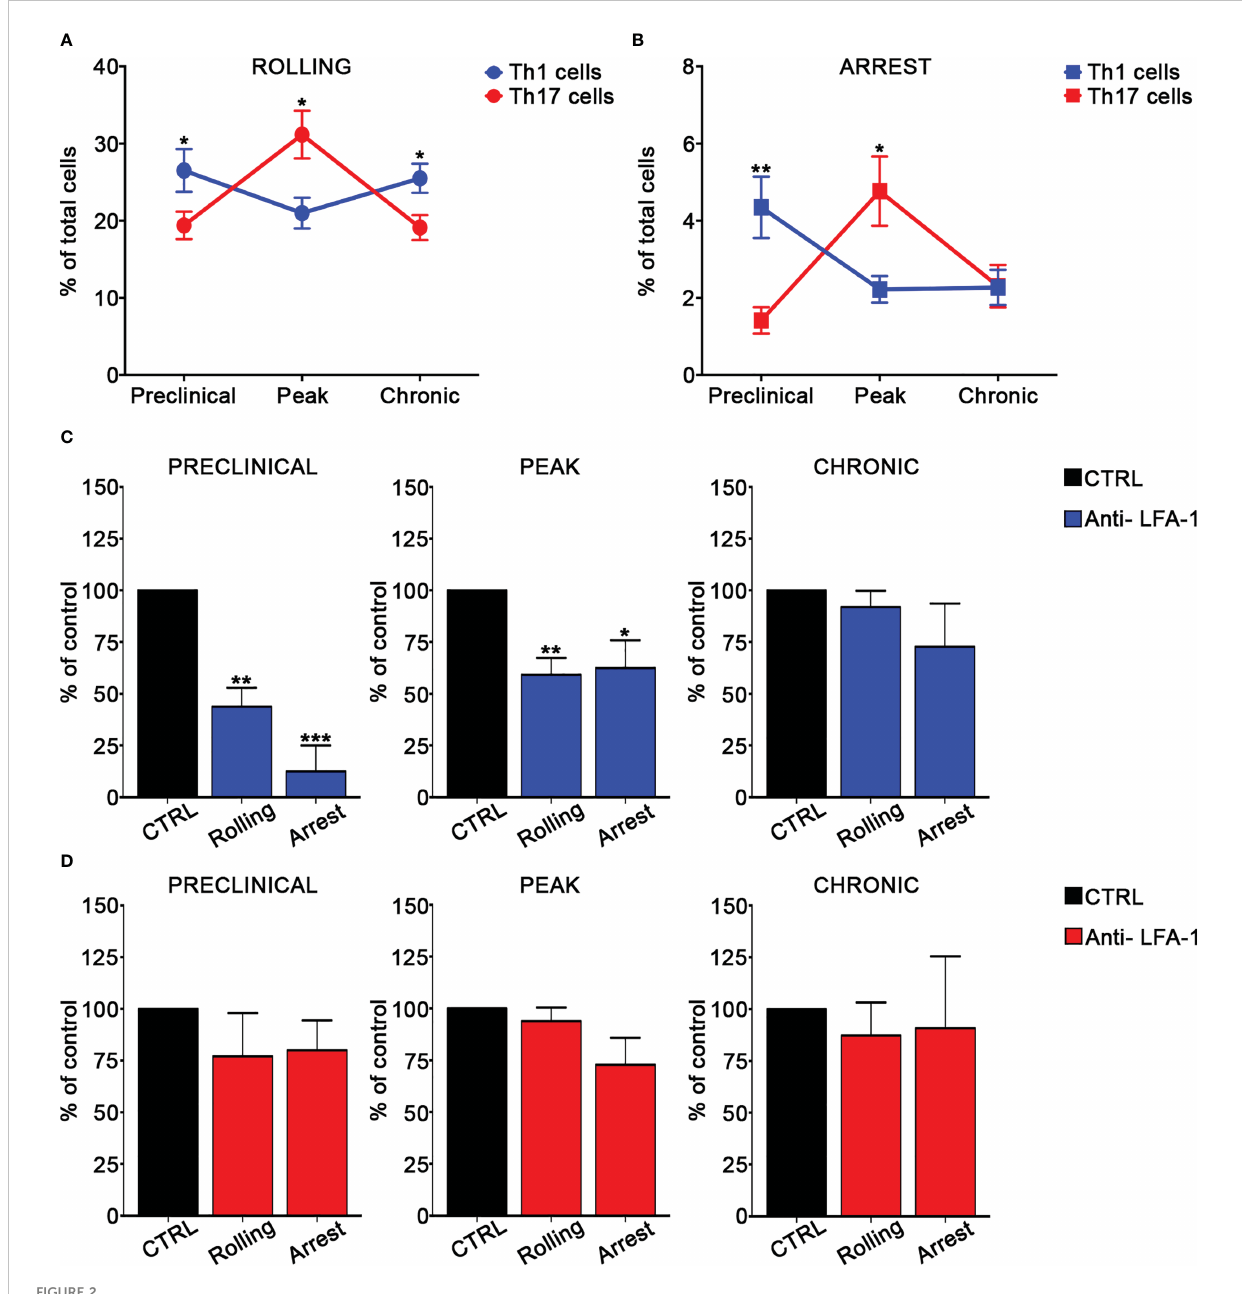
FIGURE 2 Th1 and Th17 rolling and arrest in spinal cord pial vessels during EAE. (A, B) In vitro differentiated Th1 and Th17 cells were fl uorescently labeled and co-injected in immunized mice immediately before EIVM imaging at different time point of EAE. The percentage of rolling (A) and arrest (B) of Th1 and Th17 cells was evaluated as described in material and methods. Differences in terms of percentage of rolling and adhesion between Th1 and Th17 cells at different time points were determined by using Mann-Whitney U test (one tailed). Data are expressed as mean ± SEM from three independent experiments for each time point during EAE. (* P < 0.05; ** P = 0.0026). (C, D) In vitro differentiated Th1 or Th17 cells were fl uorescently labeled, divided in two groups (untreated control cells and pretreated with the anti-LFA-1 antibody) and sequentially injected in immunized mice at different time points of EAE. EIVM imaging was performed immediately after every single cell injection at different time points of EAE. (C) Rolling and arrest of Th1 cells treated or not (CTRL) with anti-LFA-1 antibody at the preclinical phase, disease peak (2 days after the appearance of the fi rst clinical signs) and chronic EAE. (D) Rolling and arrest of Th17 cells treated or not (CTRL) with anti-LFA-1 antibody at the preclinical phase, disease peak and chronic phase of EAE. One-way ANOVA followed by Dunnett ’ s multiple comparison test was applied to compare the frequency of rolling and adhesion events after antibody treatment with of untreated control cells (considered 100%). Data are represented as mean ± SEM from a minimum of 10 to a maximum of 19 venules from three independent experiments for each condition. (* P < 0.05, ** P < 0.01; *** P <